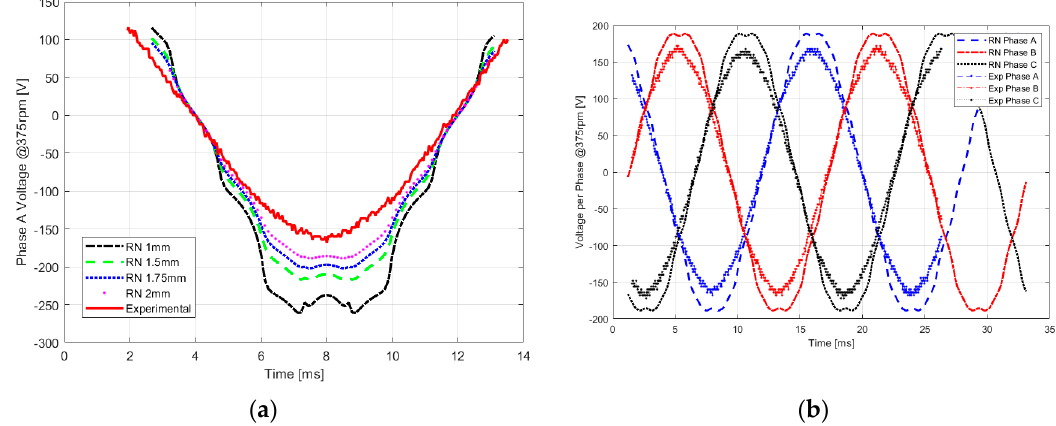
Figure 21. Comparison between the measured EMF values and the model generated ones. ( a ) Illustration on the airgap estimation study where the generated EMF from different RN models with different airgap width values were compared to the measured EMF value. ( b ) The 3 phases EMF generated from the RN model having the air gap width e = 2 mm compared to the measured 3 phases EMF.